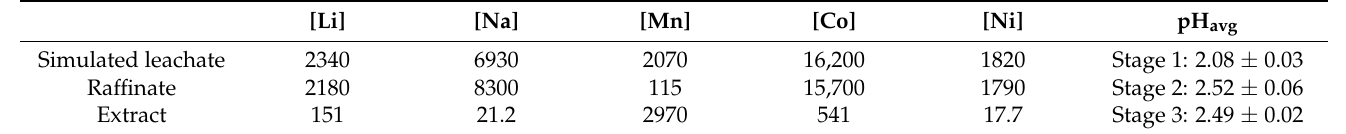
Figure 5. A McCabe–Thiele analysis applied on the equilibrium distribution of Mn between 0.8 M D2EHPA (modified by 5 vol-% TBP and diluted in Exxsol D80) and simulated LIB leachate. T = 25 ± 1 °C; pH = 2.5; t eq = 15 min. Initial aqueous concentrations [g L − 1 ]: Li: 2.63; Ni: 1.98; Co: 16.2; Mn: 2.07. The operating line was calculated with S/F = 0.8 and 99.5% Mn removal. Table 2. Compositions of the extract and raffinate in three-stage countercurrent extraction of Mn from a simulated LIB leachate by 0.8 M D2EHPA. S/F = 0.8; T = 21 ± 1 °C; τ mix = 4 min. Concentrations in [mg L − 1 ]. Numbering of the stages is started from the organic feed stage.